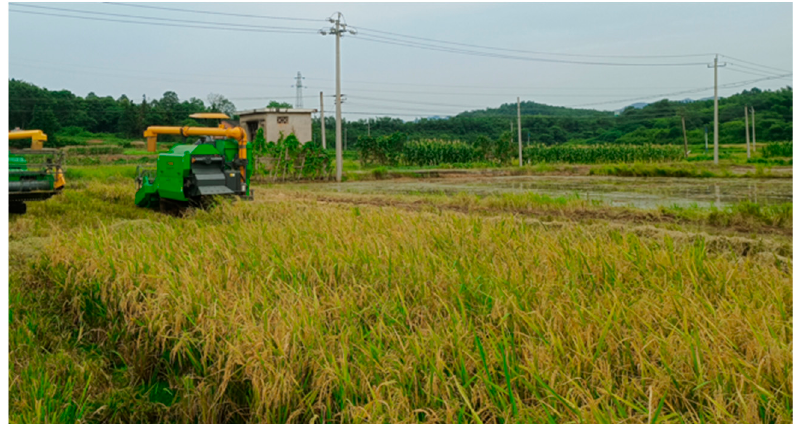
Figure 16. Harvesting trial site.